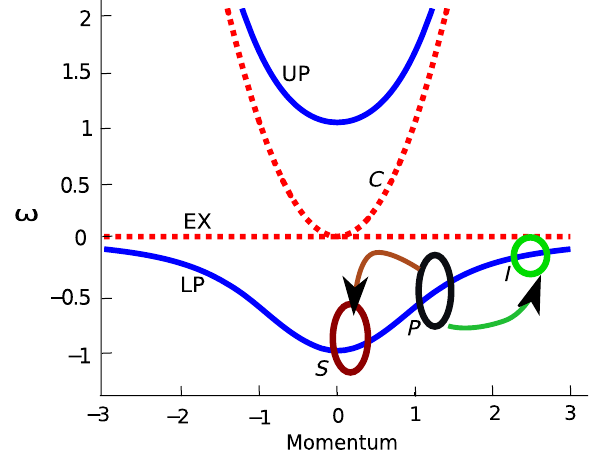
FIG. 1. Polariton system. Dispersions for the exciton (EX) and cavity photon ( C ) with zero detuning mixing to form upper (UP) and lower polaritons (LP). The external drive introduces pairs of lower polaritons with momentum k scatter into the signal ( S ) and idler ( I ) states while conserving energy and